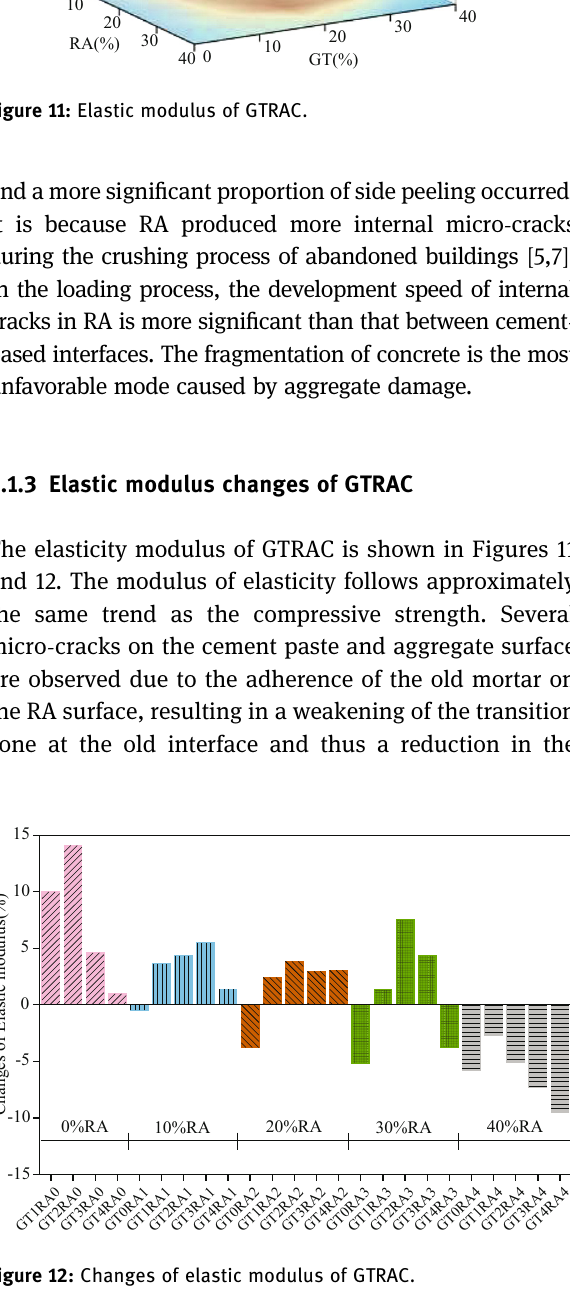
Figure 12: Changes of elastic modulus of GTRAC.